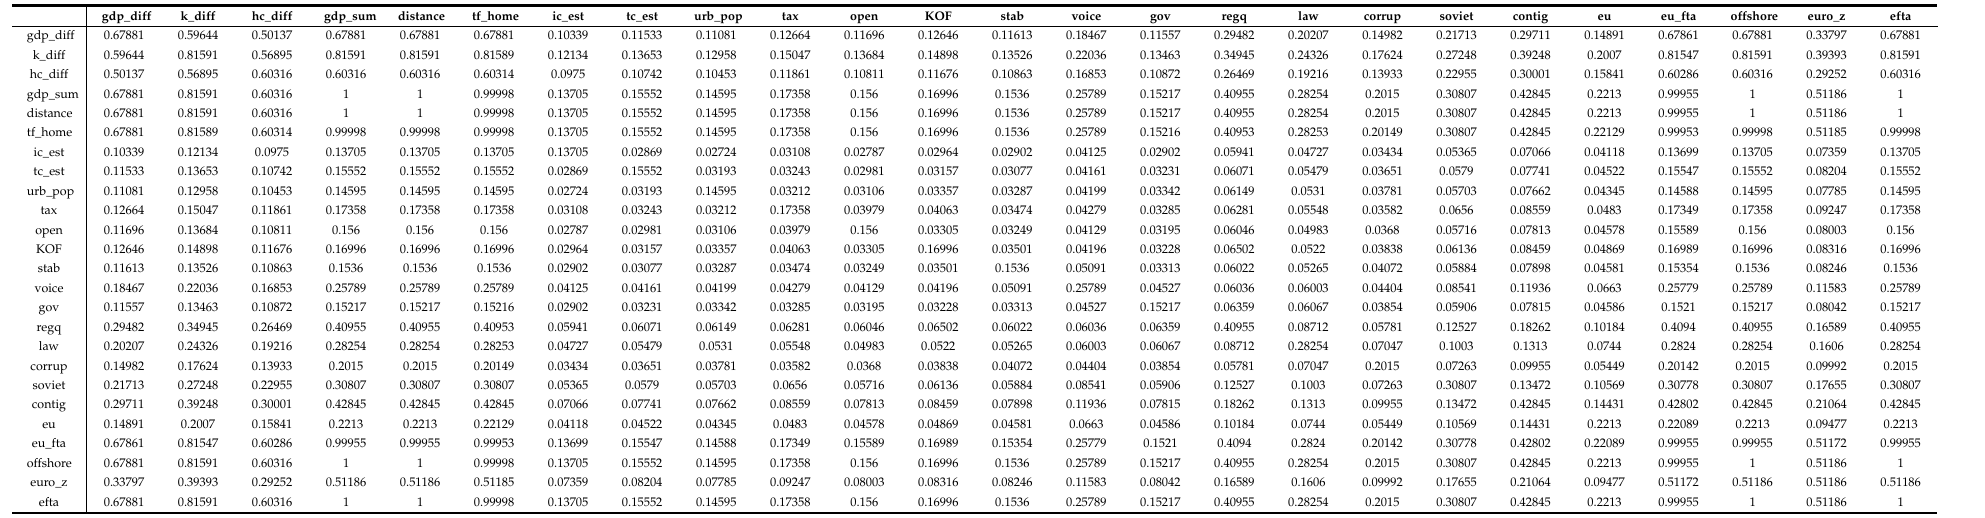
Table A8. Estonia, general case: the joint inclusion probability matrix for all